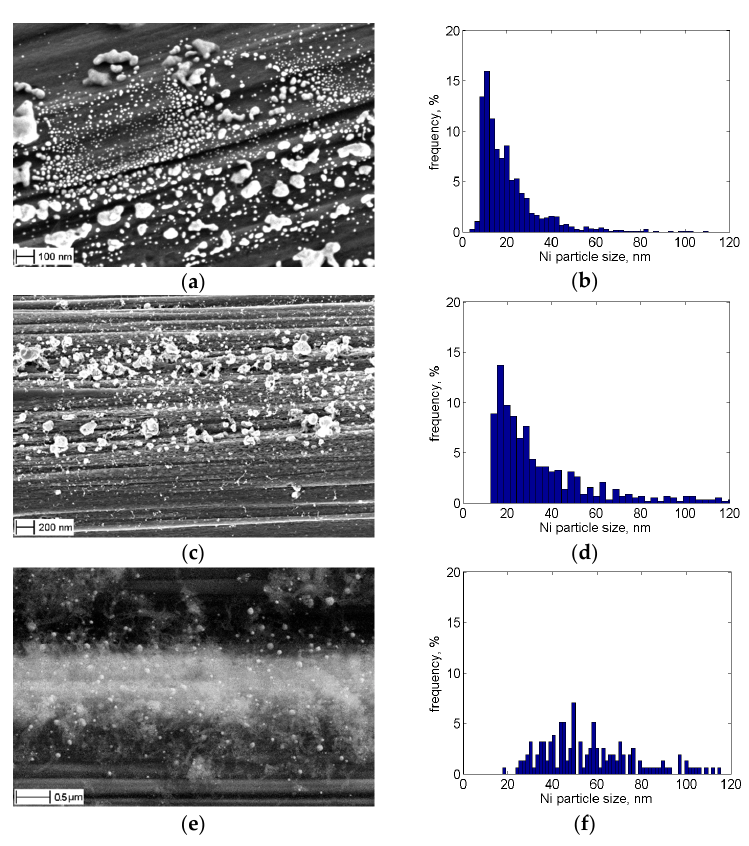
Figure 7. Ni particles in the fabric without CNF growth ( a , b ); or after a 0.7 wt % CNF growth ( c , d );